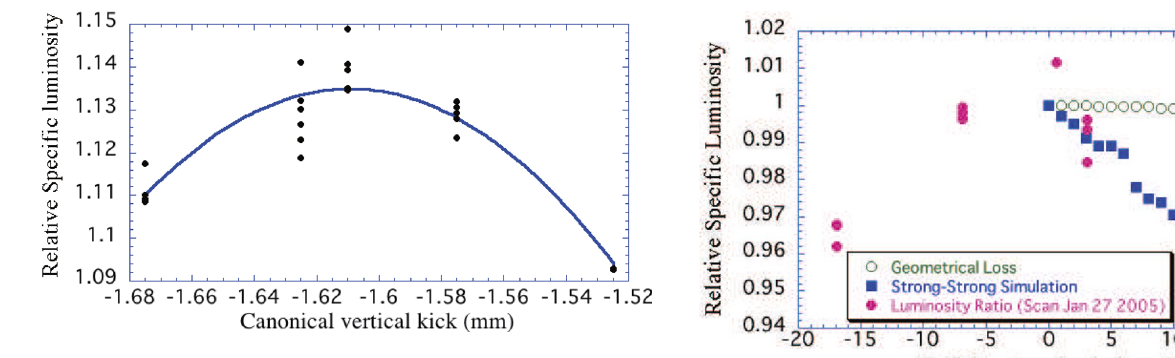
4. (Color) Typical result of the target scan of the vertical offset. A fitted curve using a quadratic function is also